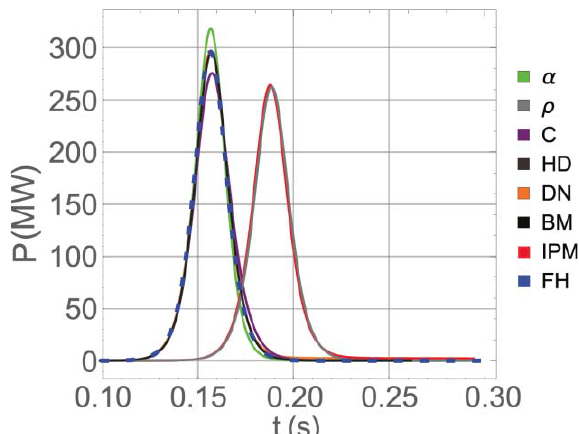
Figure 2: Comparison of power from IPM (red) and FH (blue) for 2 $ inserted reactivity. Individual improvements of IPM are also shown (basic model and basic model with each